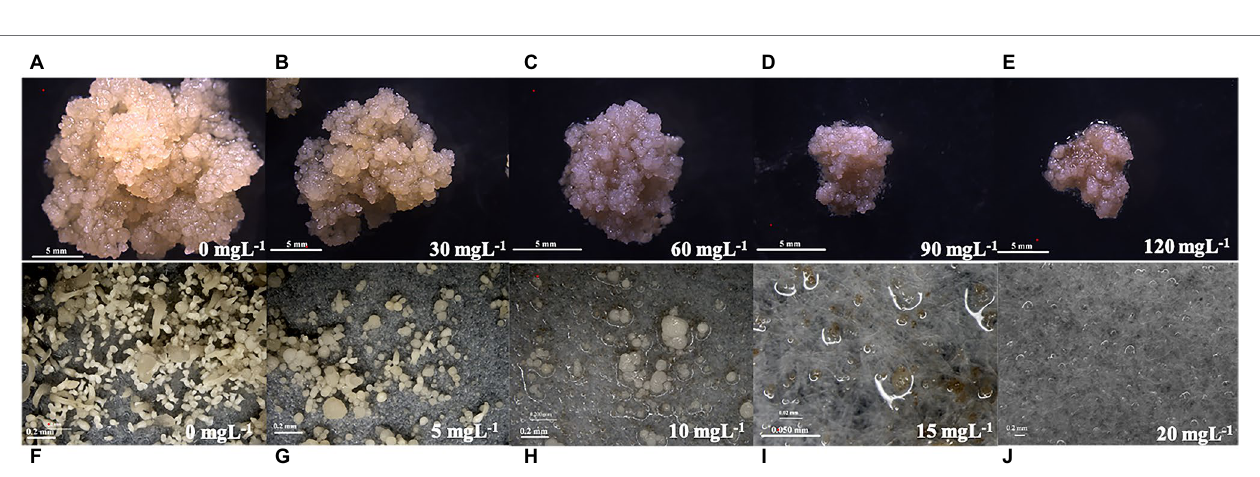
FIGURE 2 | The sensitivity of embryogenic calli and somatic embryos of the Liriodendron hybrid to Geneticin (G418). (A) The relative fresh weight of the embryogenic callus under the different concentrations of G418. (B) The regenerative capacity of somatic embryos of the Liriodendron hybrid under G418 stress at 0, 5, 10, 15, and 20 mg L − 1 . Callus relative fresh weight is the difference between secondary callus fresh weight and initial callus fresh weight. Each replicate includes 30 embryogenic callus masses per dish. Data correspond to the mean ± SD of three replicates. An ANOVA test was used for statistical analysis. Column bars with the different letters indicate significant differences at p < 0.05 by Tukey test.